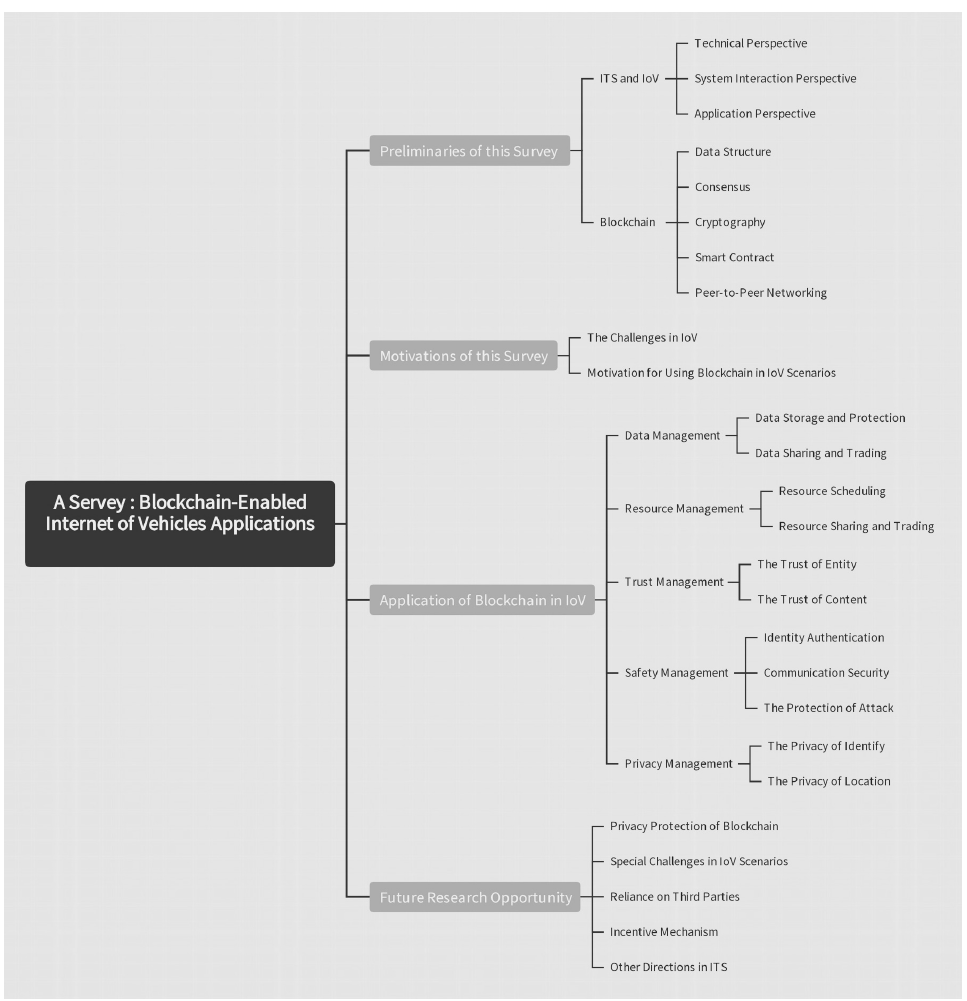
Figure 1. Structure of This